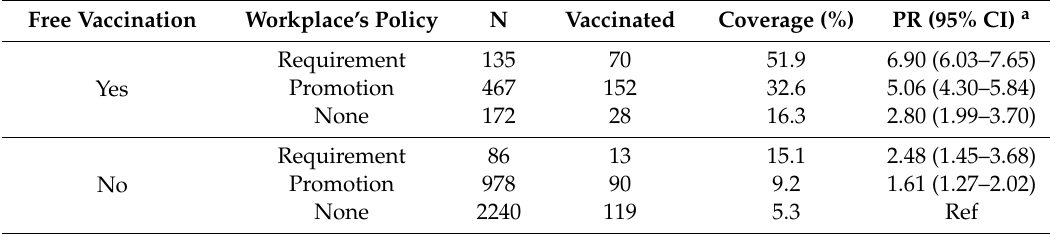
Table 3. Influenza vaccine coverage in healthcare workers by policy options in 2018–2019